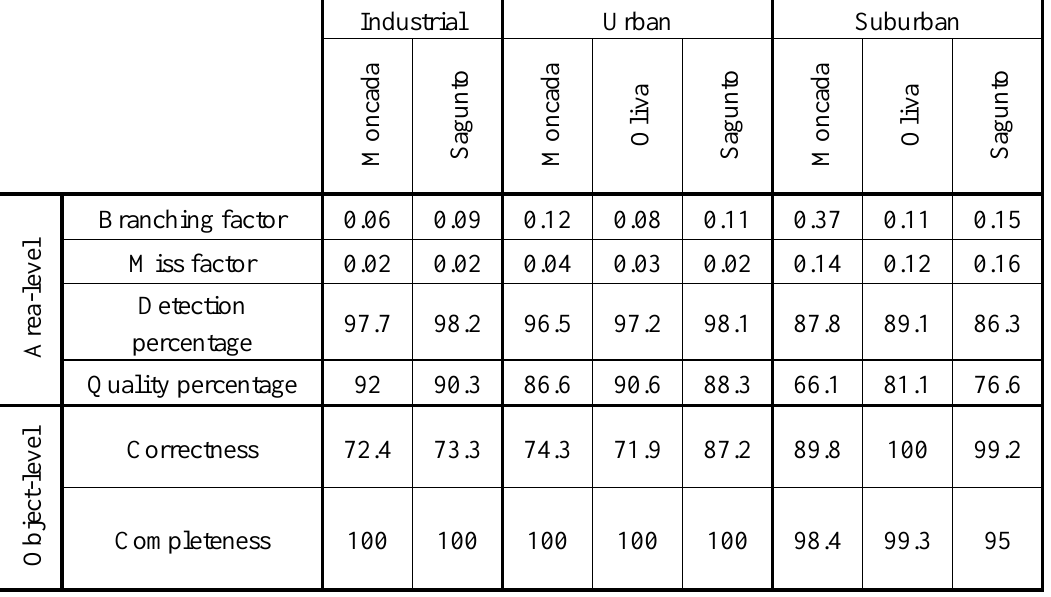
Table 2. Evaluation results for the thresholding-based approach.